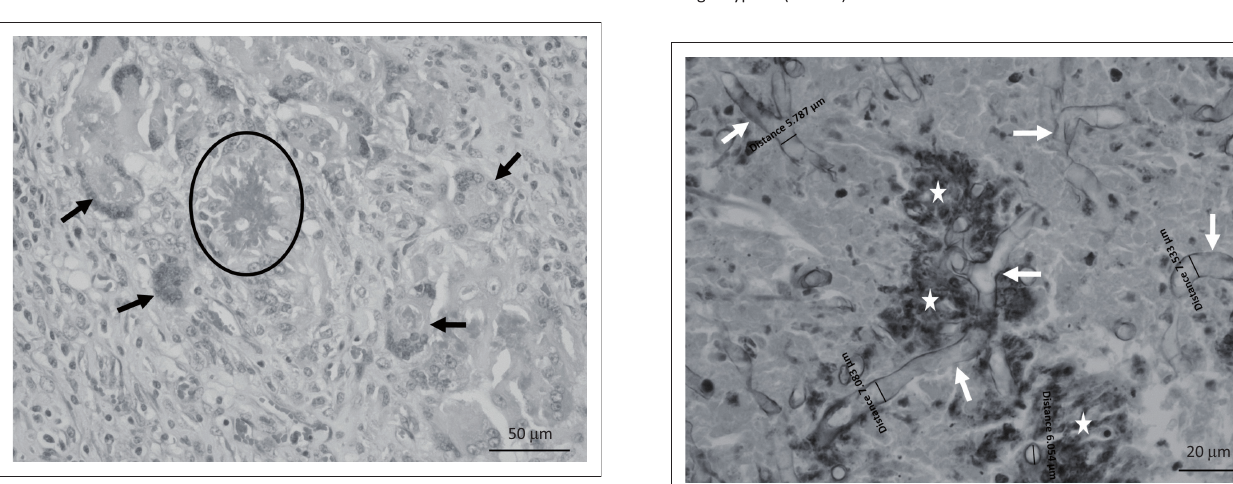
FIGURE 2: Hyper-eosinophilic Splendore-Hoeppli foreign material (circle) encasing ghost-like (negative H&E staining), pipe-shaped structures typical of fungal hyphae (arrows).